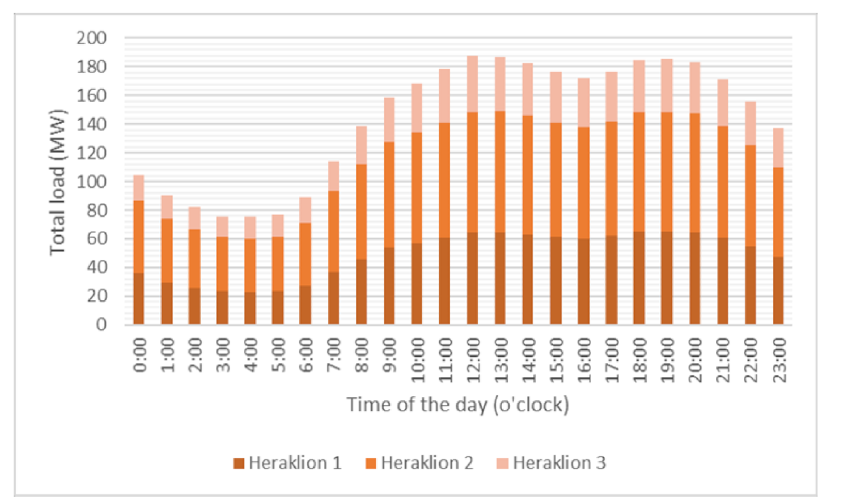
Figure 5. High voltage substations